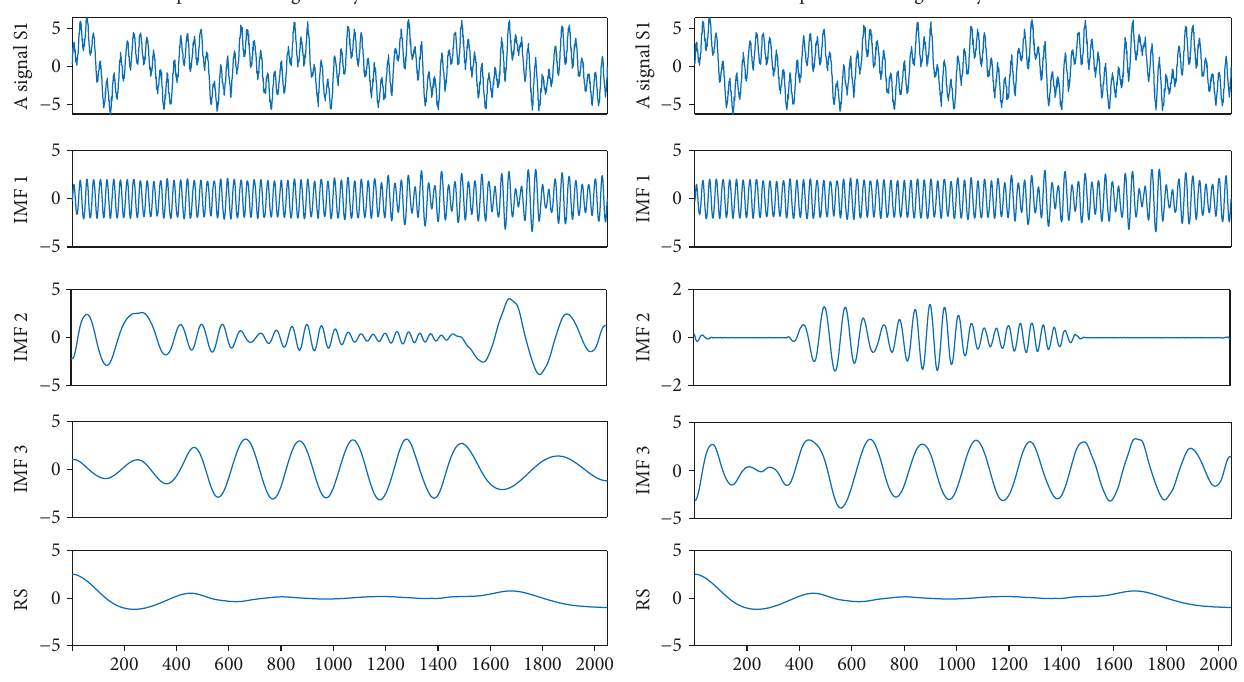
Figure 5: The decomposition of reconstructed signal S